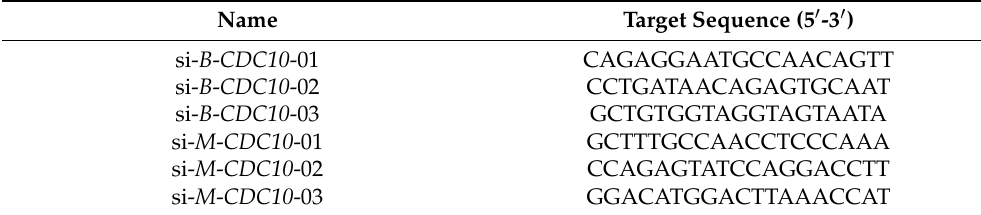
Table 1. Bovine and murine CDC10 siRNA target sequences.